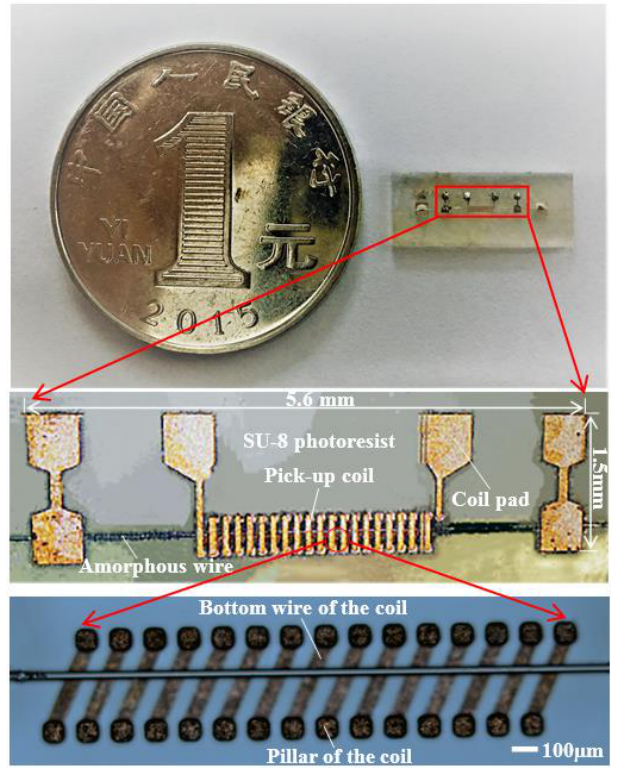
Figure 6. Fabricated amorphous wire GMI (Giant magneto-impedance) magnetic sensor probe. The bottom wire of coil is placed at an angle relative to the amorphous wire.